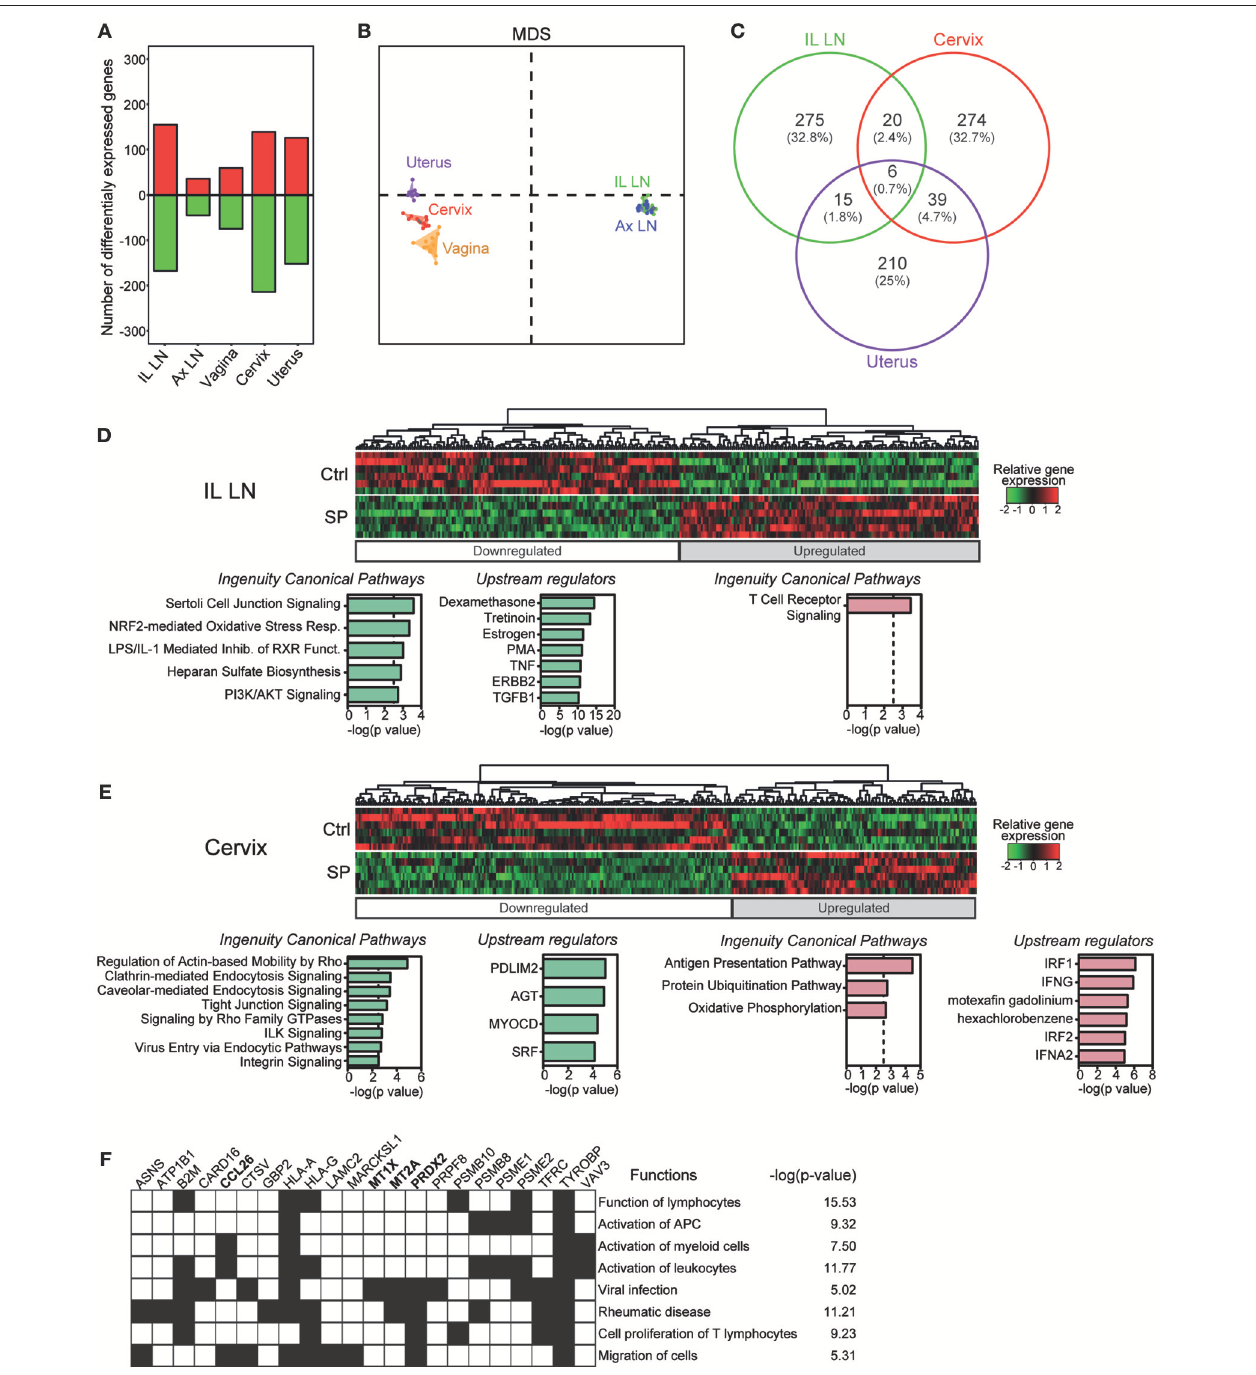
FIGURE 4 | SP exposures impact mainly immune-related gene expression in the cervix. (A) Number of down-regulated (green) and upregulated (red) genes affected by SP exposures in the various compartments. (B) MDS representation of the whole dataset based on the DEG list for at least one condition. (C) Venn diagram showing the overlap between the list of DEG in the iliac LN, cervix and uterus. Heatmaps of relative gene expression in the iliac LN (D) and cervix (E) . Associated canonical pathways and upstream regulators for down-regulated (green) and up-regulated (red) genes are detailed. (F) Biological processes found to be significantly over-represented ( p < 0.05) in the lists of up-regulated genes targeted by upstream regulators in cervix. The main associated functions are shown.